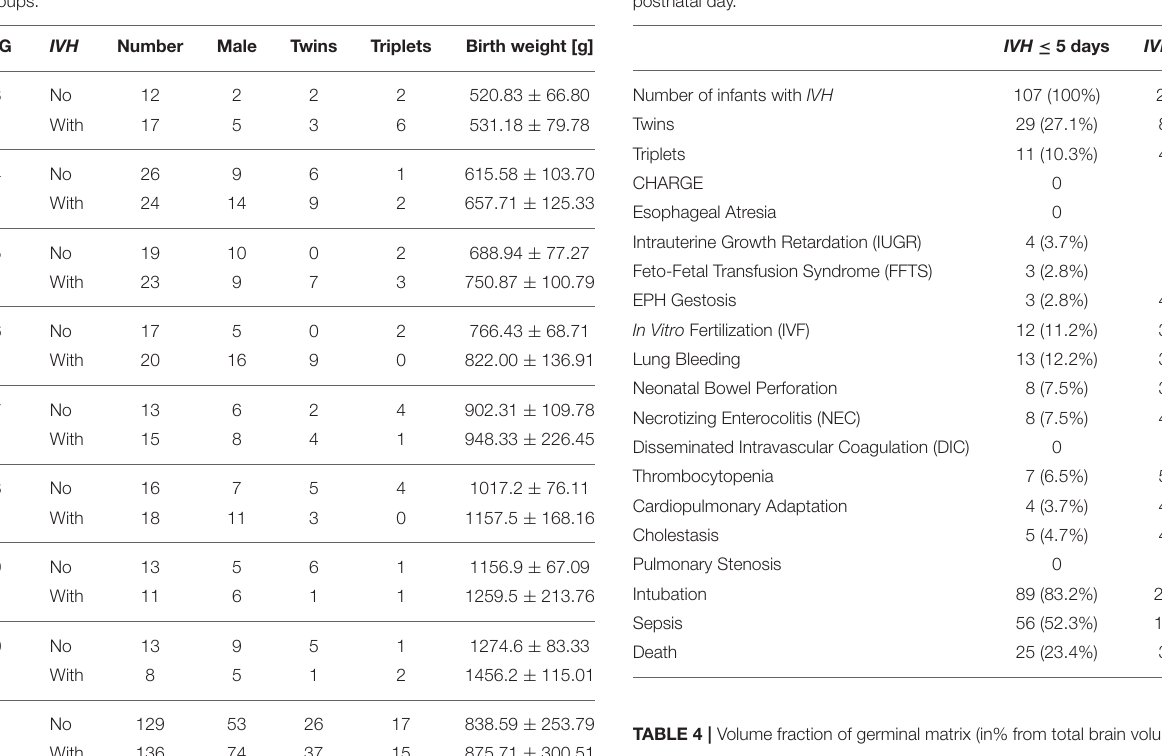
TABLE 3 | Baseline clinical parameters for infants with IVH before and after 5th postnatal day.